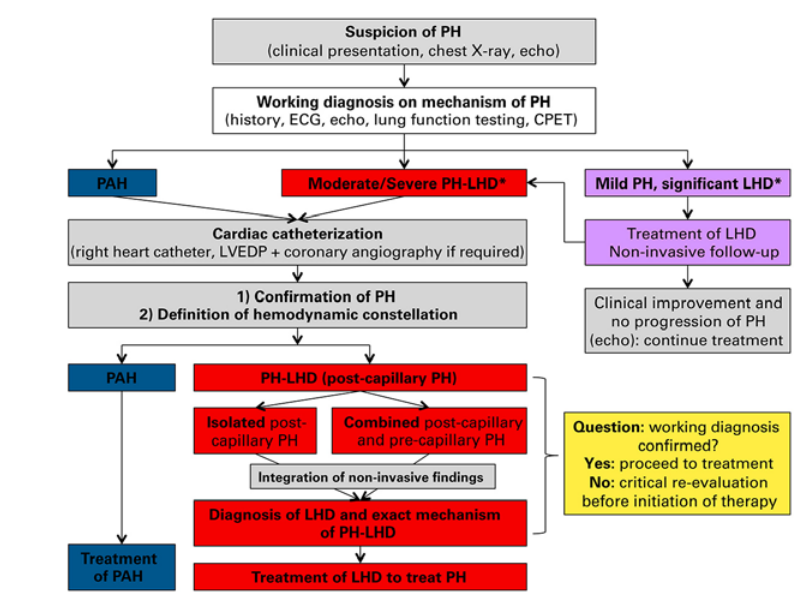
Important echocardiographic features for the assessment of the patient with suspected pulmonary hypertension. Direct (elevated peak tricuspid regurgita- tion velocity) and indirect (right ventricu- lar dilatation, hypertrophy, and dysfunc- tion as well as right atrial dilatation) are seen in all forms of pulmonary hyperten- sion. In general, evidence of significant pulmonary hypertension without evi- dence of left-sided heart disease sug- gests pulmonary arterial hypertension, particularly if the right ventricle and right atrium are bigger than the left ventricle and the left atrium, and there is evidence of higher right atrial than left atrial pres- sure (atrial septum bulged to the left). In contrast, signs of pulmonary hyperten- sion combined with evidence of signifi- cant left-sided heart disease suggest PH- LHD, particularly if there is evidence of higher left atrial than right atrial pressure (left atrium bigger than right atrium, and atrial septum bulged to the right). CW = continuous wave; LA = left atrium; LV = left ventricle; PW = pulsed wave; RA = right atrium; RV = right ventricle; TAPSE = tricuspid annular plane systolic excursion